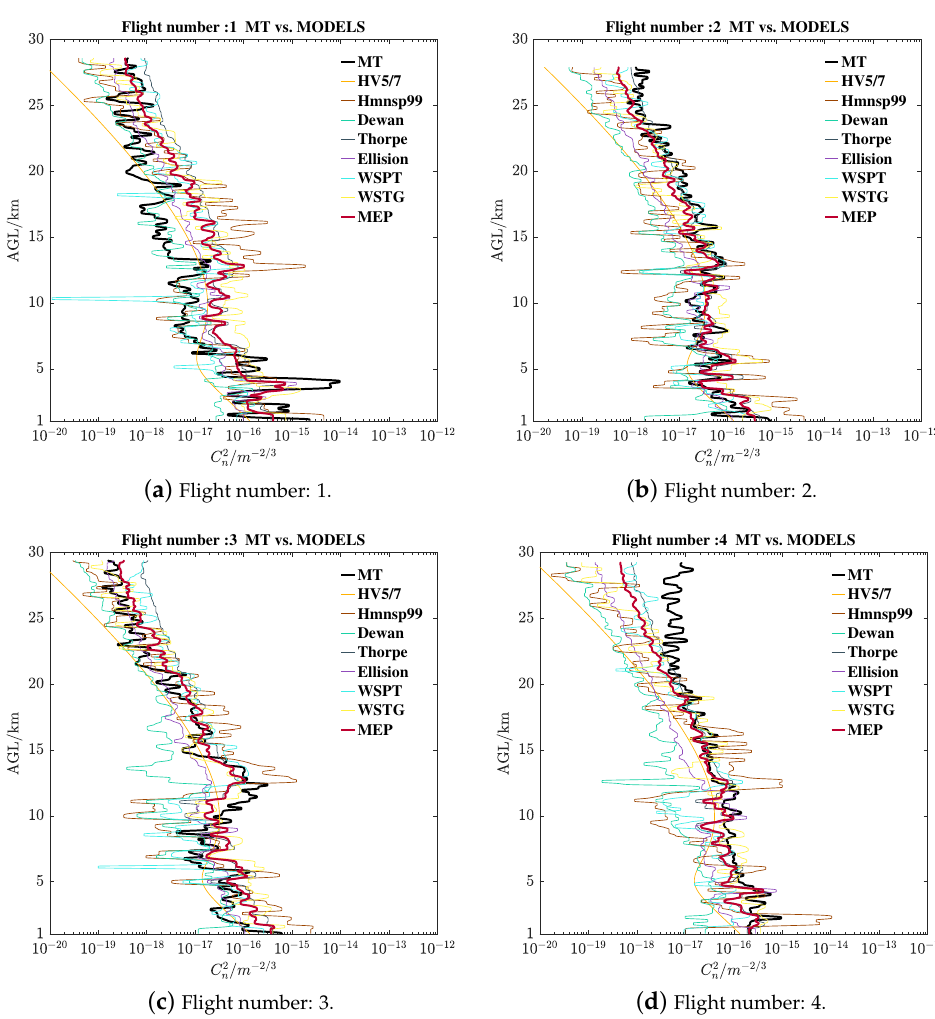
Figure A4. The refractive index structure parameter profiles of MT and estimations in NCACN: Figure A4 sub-figures ( a – d ) are flight numbers 1–4 in Table